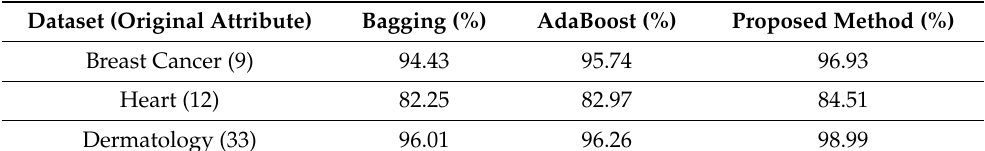
Table 1. Comparative Classification accuracy for other disease datasets.